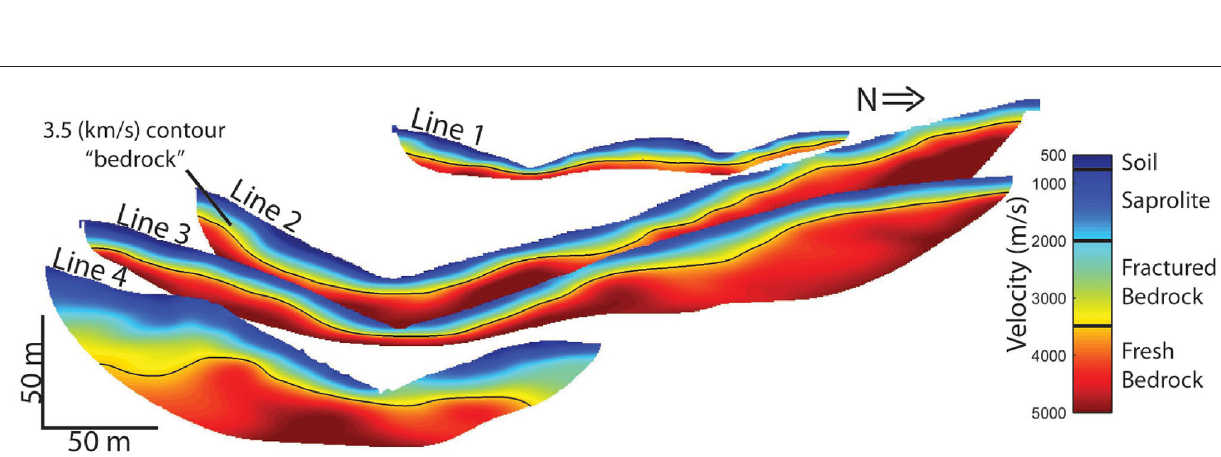
water content at lower elevations. Hence, we propose